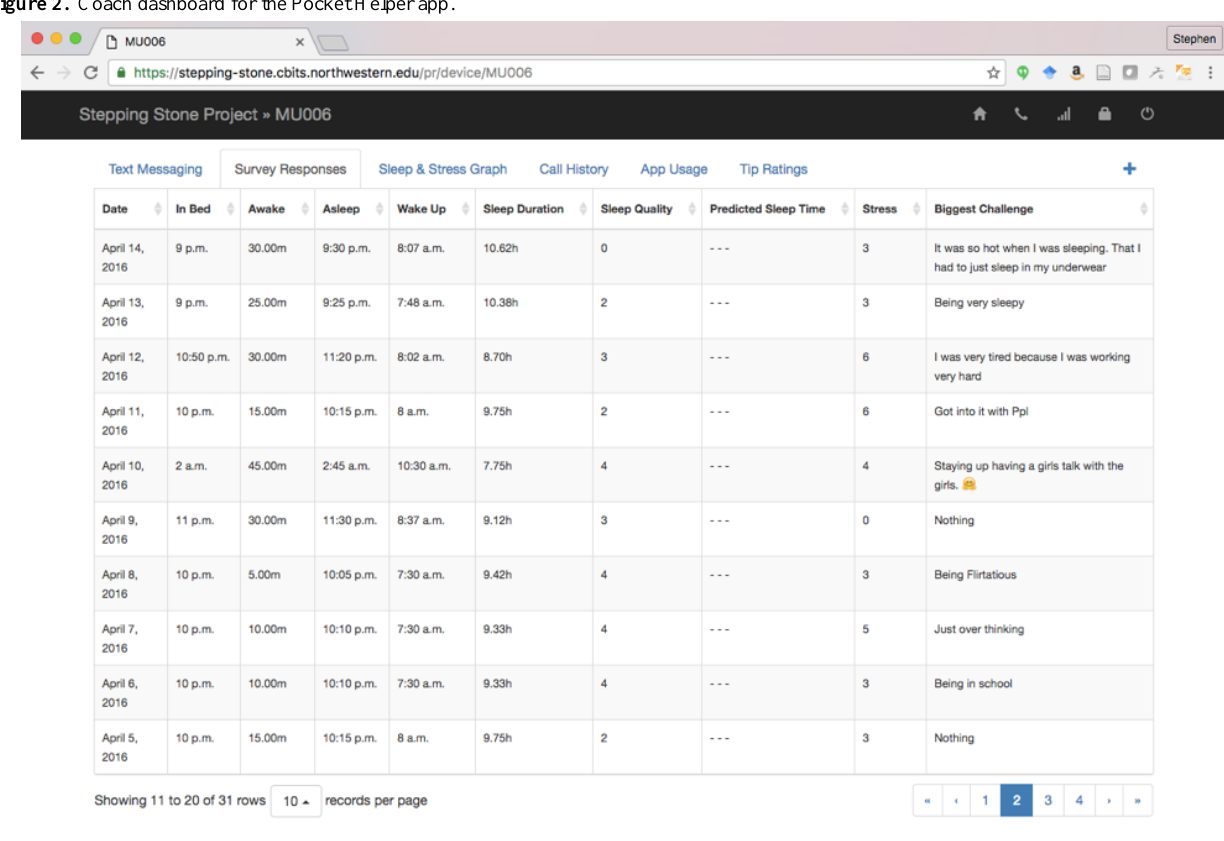
Figure 2. Coach dashboard for the Pocket Helper